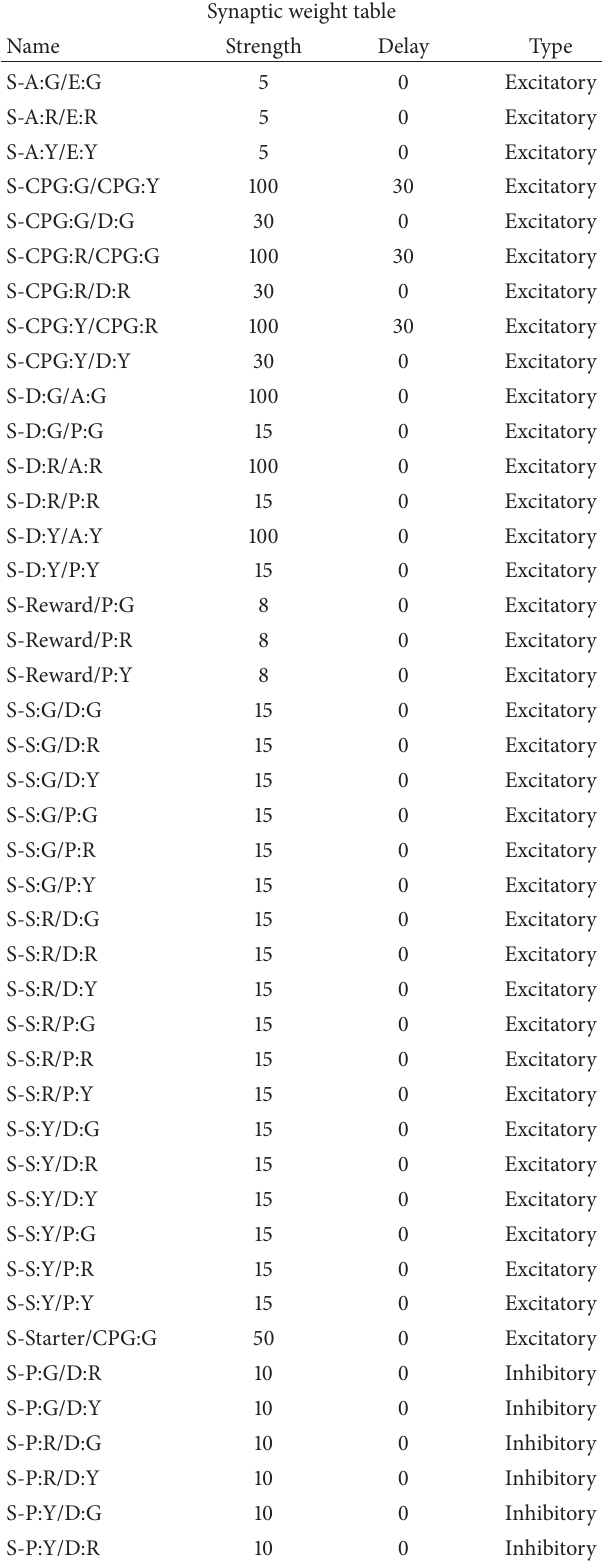
Table1:SynapticweightsassociatedwiththeSNNofFigure 4.These are represented by numerical percentage values. Delays in cycle as well as the type of the synapse are also mentioned.